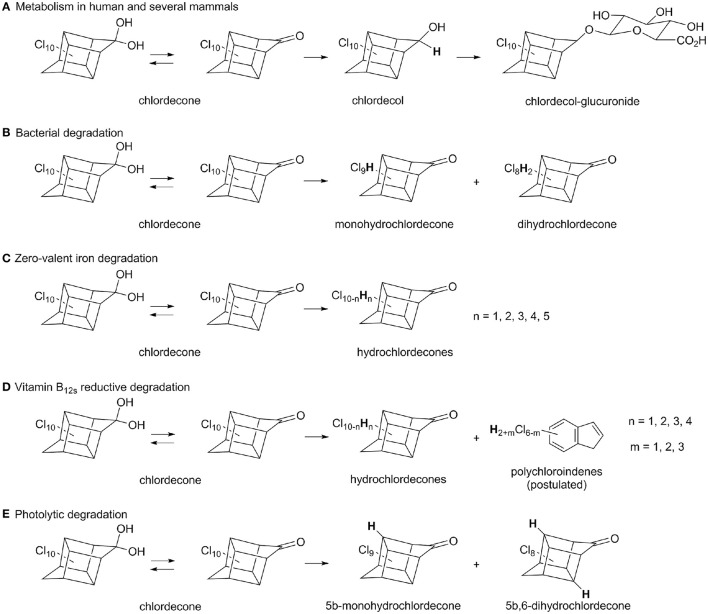
Summary of known metabolic and degradative pathways for chlordecone: (A) human and mammals metabolism (Fariss et al., 1980; Houston et al., 1981; Soine et al., 1983), (B) aerobic and anaerobic bacterial degradation (Orndorff and Colwell, 1980; George and Claxton, 1988), (C) zero-valent iron degradation (Mouvet et al., 2016), (D) vitamin B12s reductive degradation (Schrauzer and Katz, 1978), (E) photolytic known degradation (Wilson and Zehr, 1979). For clarity, hydrated ketone moiety was only represented for chlordecone, even if it presumably occurs for all hydrochlordecones.